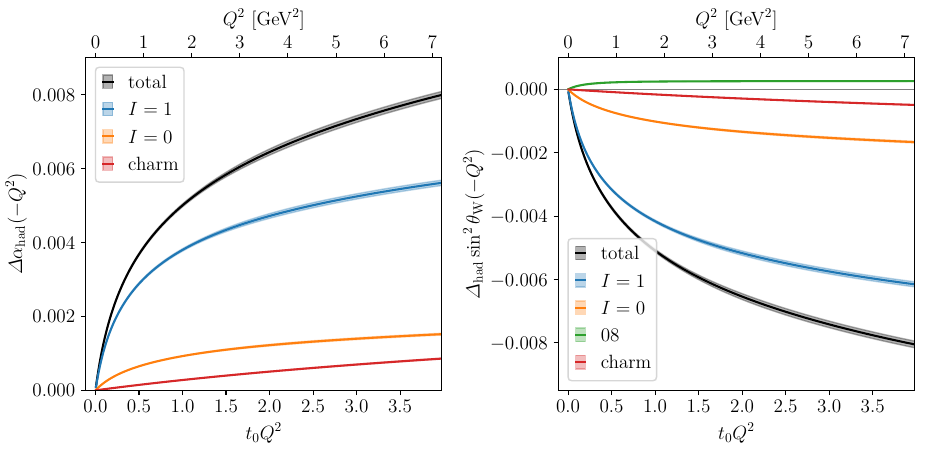
Figure 10 . Total HVP contribution to the running of α (left panel) and sin 2 θ W (right panel) as a function of Q 2 , together with the I = 1 , I = 0 , charm and, for sin 2 θ W , Zγ -mixing contributions.